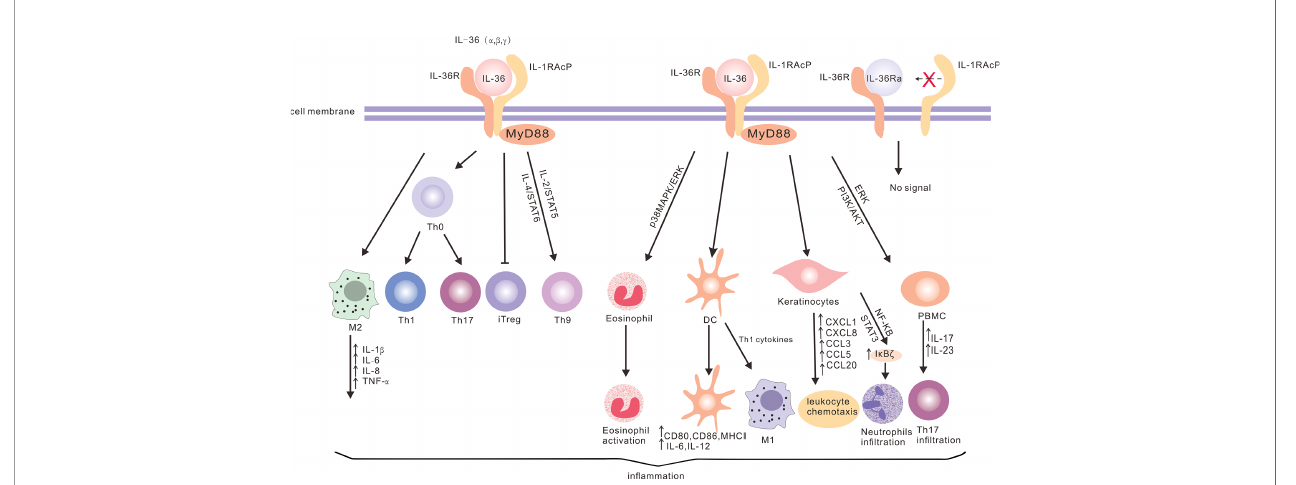
FIGURE 1 | The production of IL-36 cytokines and the downstream signaling network. IL-36 can bind to IL-36R on a variety of cells (such as keratinocytes, dendritic cells, T cells, eosinophils, PBMCs and macrophages) through different signaling pathways to produce cytokines and chemokines, and promote neutrophil and eosinophil in fi ltration, T cell proliferation and macrophage polarization, in order to promote in fl ammation. However, IL-36Ra acts as an antagonist of IL-36R without activating the downstream